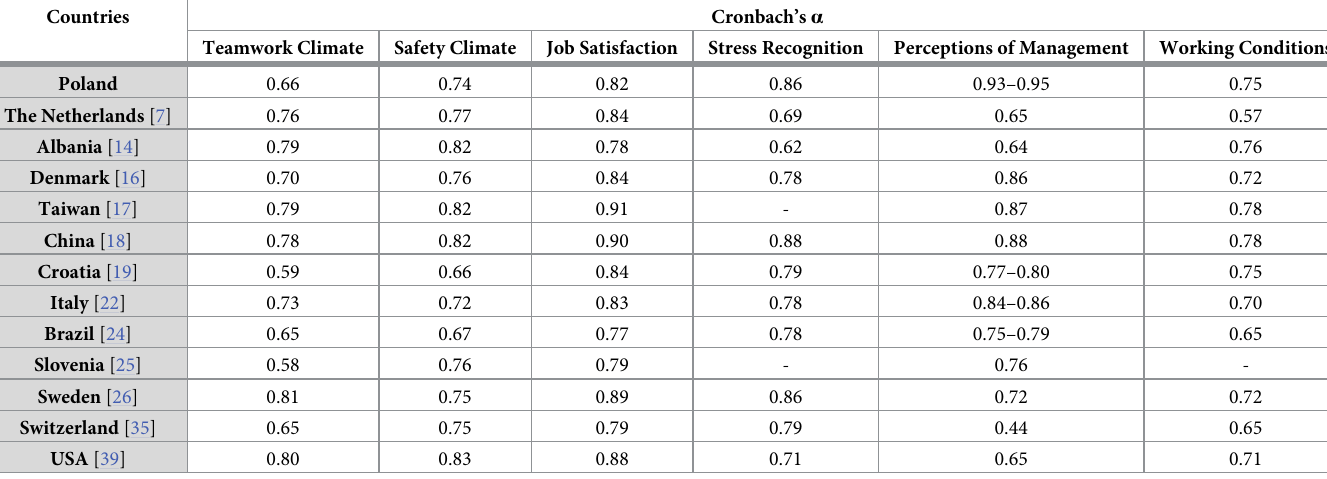
Table 5. Results Polish version of the SAQ-SF compared with other countries.